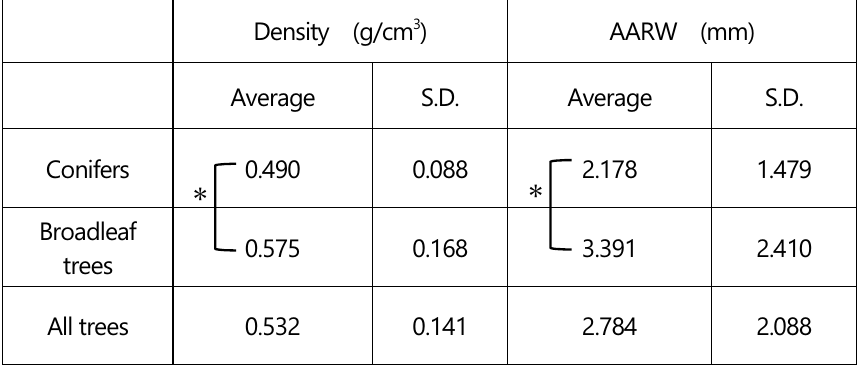
Table 4 shows the results of paired mean difference tests between each measured L * of each plane in Fig. 4.